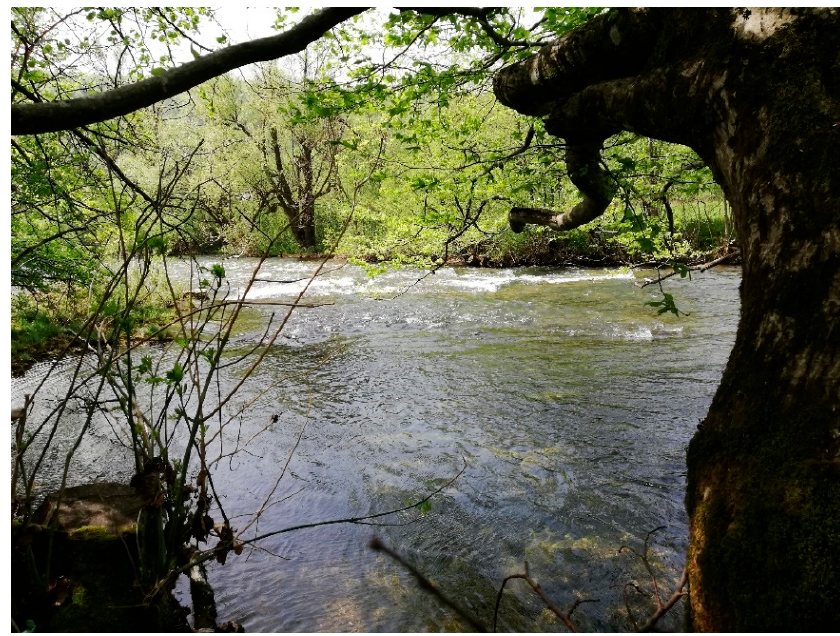
Figure A2. View of the location of the measuring station Turkovi ć i on the Gornja Dobra River.